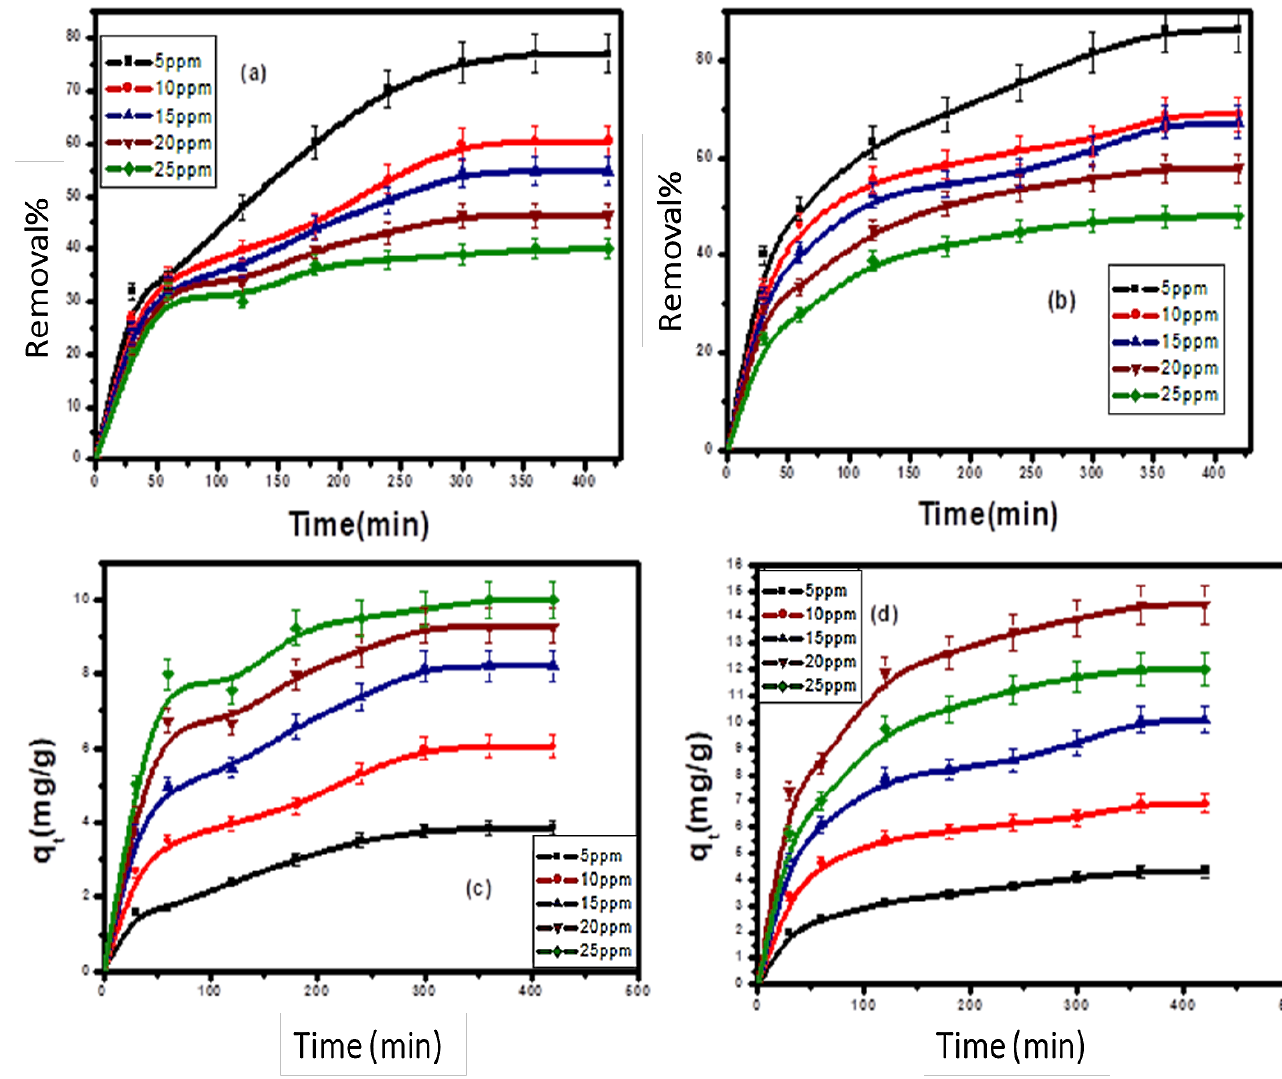
Figure 4. Effect of CR dye concentrations and contact time on the removal % and amount of adsorbed dye at 25 °C and pH 7 by 20 mg of ( a , c ) Gl, and ( b , d ) Gl/PAN nanocomposite. The amount of adsorbed CR increases as the initial CR concentration increases, as seen in Figure 4c,d. This might be explained by the fact that as the initial CR concentration was raised, the concentration gradient grew. As a result, the mass transfer barrier between the CR adsorbate and the Gl and Gl/PAN nanocomposite adsorbents is appropriately ob- scured by rising draught forces. Maximum Gl adsorption capacities were found to be 3.8, 6, 8, 2, and 10 mg/g, while Gl/PAN composite adsorption capacities were found to be 4.3, 6.8, 10, and 12 mg/g for CR with starting concentrations of 5, 10, 15, and 25 mg/L, respec- tively, at pH 7 and 25 °C. The outcomes demonstrated that the modification of Gl with PAN is a workable strategy to improve the effectiveness of CR elimination. 3.2.2. Effect of Adsorbent Doses To determine the ideal adsorbent dosage that provides the greatest efficiency, the impact of adsorbent mass on CR removal percentage was evaluated to compute the ad- sorption cost, as illustrated graphically in Figure 5a. Adsorbent dosages varied from 0.02 to 0.1 g. It has been discovered that 0.02 g of adsorbent per 20 mL of CR solution with a starting concentration of 5 mg/l provides the maximum level of efficiency. The elimination